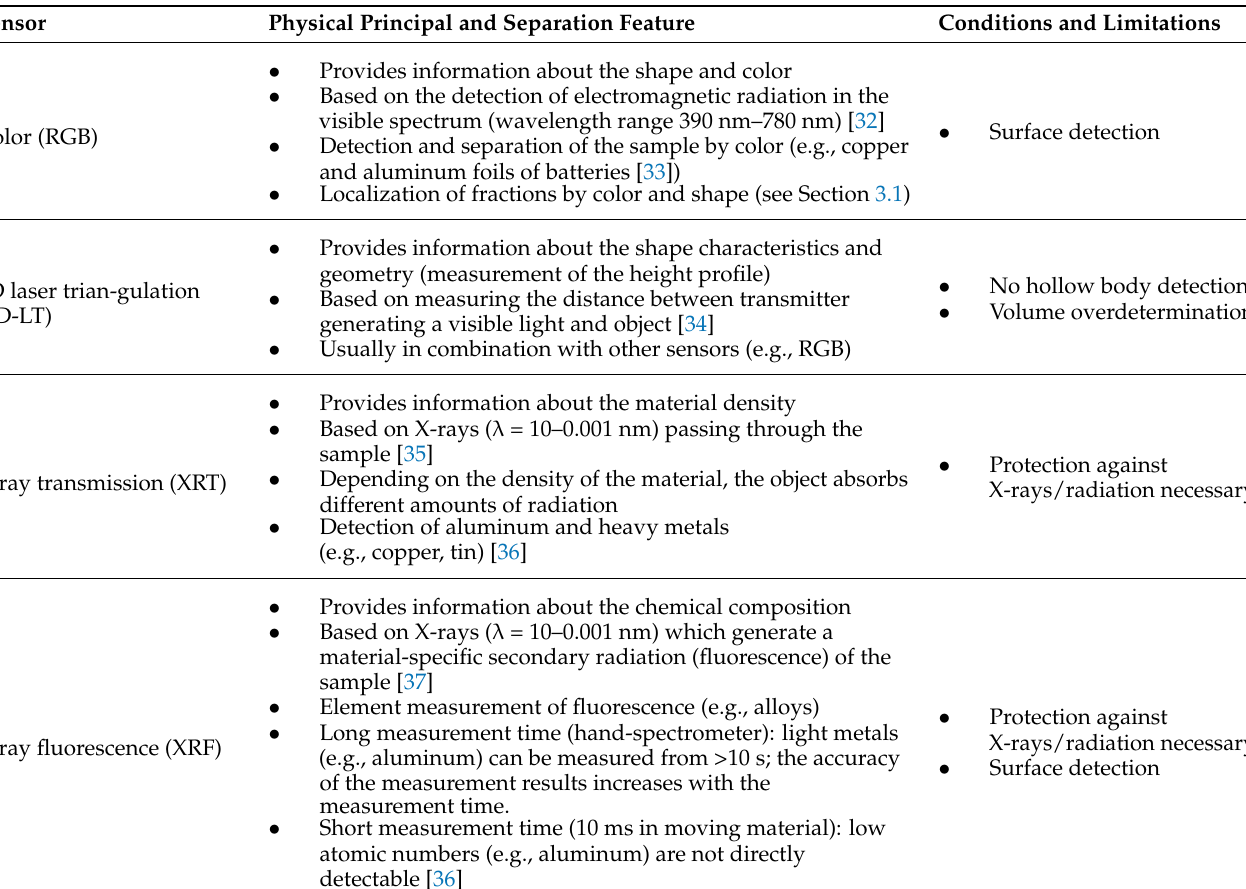
Table 1. Sensor technologies in circular economy. Physical principal and